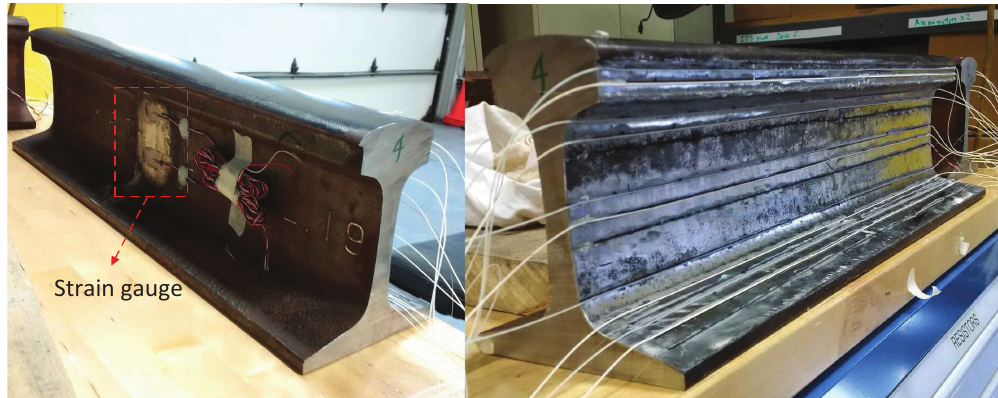
Figure 1. Rail specimen instrumented with strain gauge and optical fibers on each side.